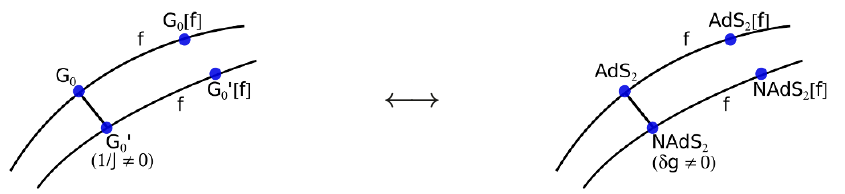
Figure 1 . In the left panel, the top curve represents the Diff( R )-orbit (or a Diff( S 1 )-orbit at finite temperature), at the IR fixed point J = , of the classical large N solution for the fermion bilocal ∞ G 0 ( τ 1 , τ 2 ) ( τ 1 τ 2 ) − 2∆ ; this represents the Nambu-Goldstones of Diff( R )/ SL (2 , R ). The lower ∼ − curve represents the orbit of a deformed solution G ′ slightly away from the IR fixed point, with 0 a small positive 1 /J . In the right panel, the top curve represents the orbit of the AdS 2 spacetime (these are asymptotically AdS 2 spacetimes, the two-dimensional equivalent of Brown-Henneaux geometries, which we will describe explicitly in section 4). The bottom curve represents the orbit of a slightly deformed AdS 2 spacetime NAdS 2 , with a controlled non-normalizable deformation (see section